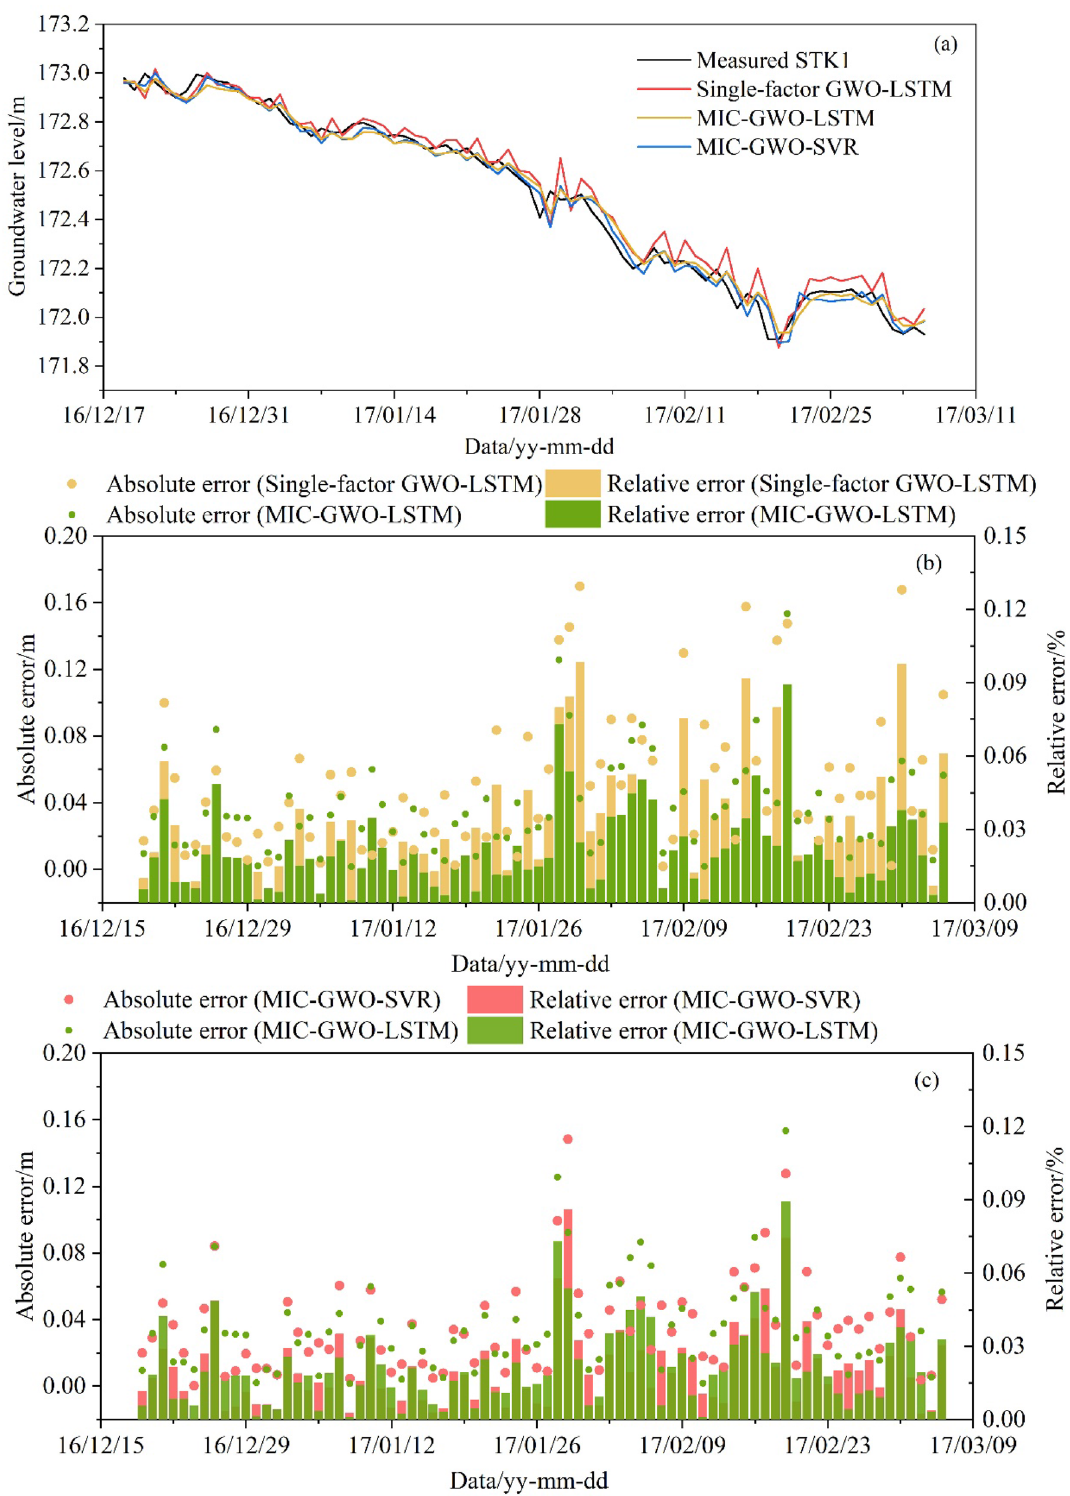
Figure 17. Prediction result of the validation set. ( a ) Direct prediction of the GWL by the LSTM and SVR models, ( b ) the absolute error and relative error of the Single-factor GWO-LSTM model and the MIC-GWO- LSTM model, ( c ) the absolute error and relative error of the MIC-GWO-SVR model and the MIC-GWO-LSTM